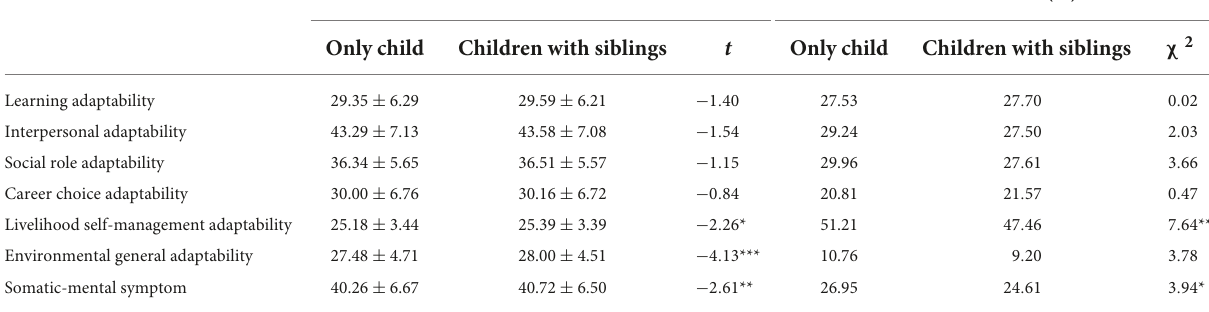
TABLE 3 The differences between only child and children with siblings undergraduates on primary study